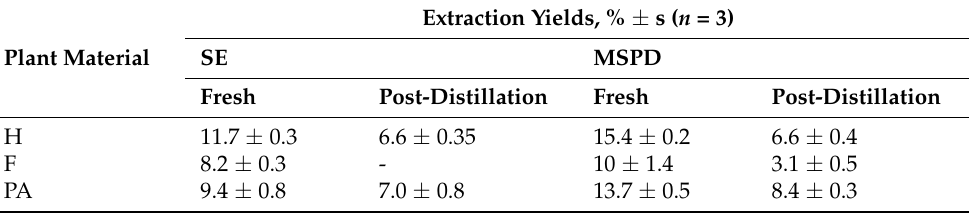
Table 1. Extraction yields of fresh and post-distillation plant material with the different extraction techniques